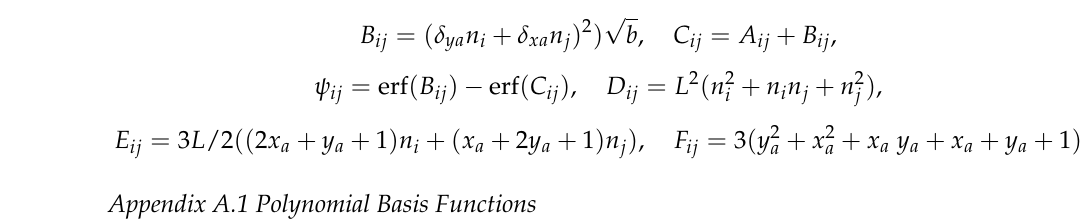
Table A1. Number of polynomial terms based on the degree of polynomial.